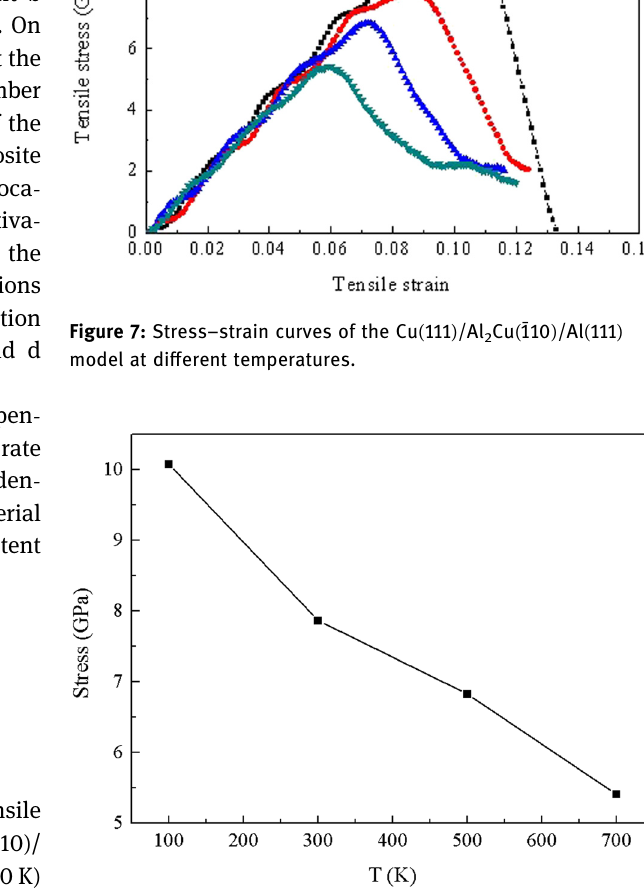
Figure 8: Ultimate tensile strength curves at di ff erent